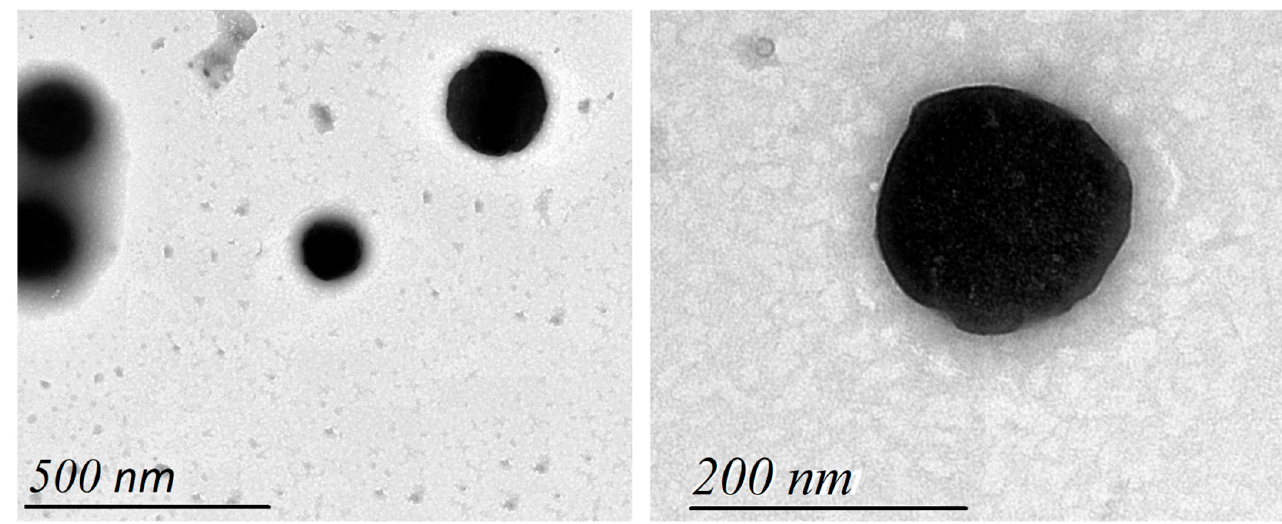
Figure 1. DSC of optimum ALN formulation and its individual constituent.